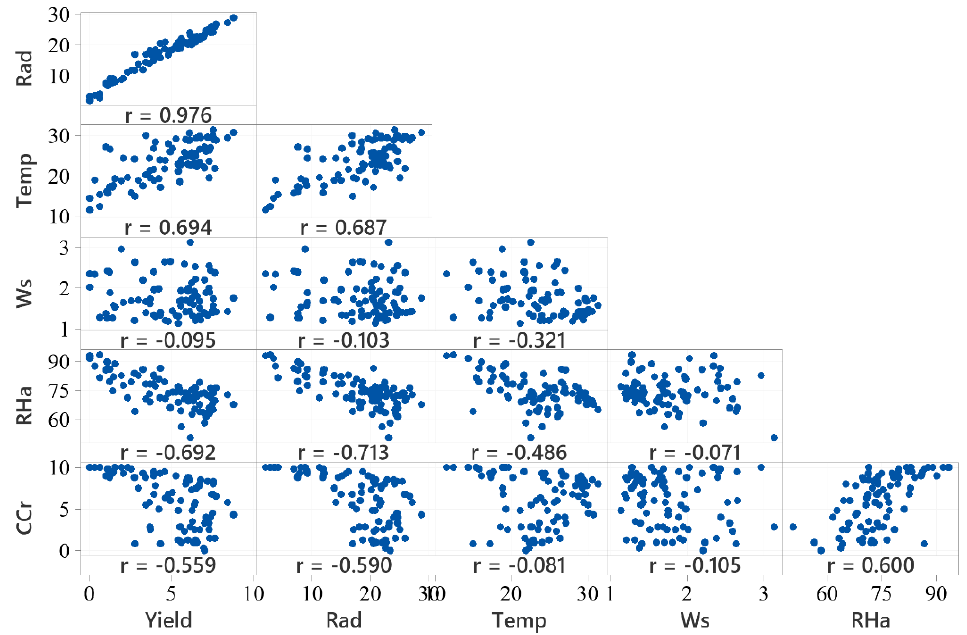
Figure 6. Matrix plot of Pearson’s correlation showing the extent of correlation between the variables yield, cloud cover (CCr), ambient relative humidity (RHa), wind speed (Ws), ambient temperature (Temp), and daily total global solar radiation (Rad).